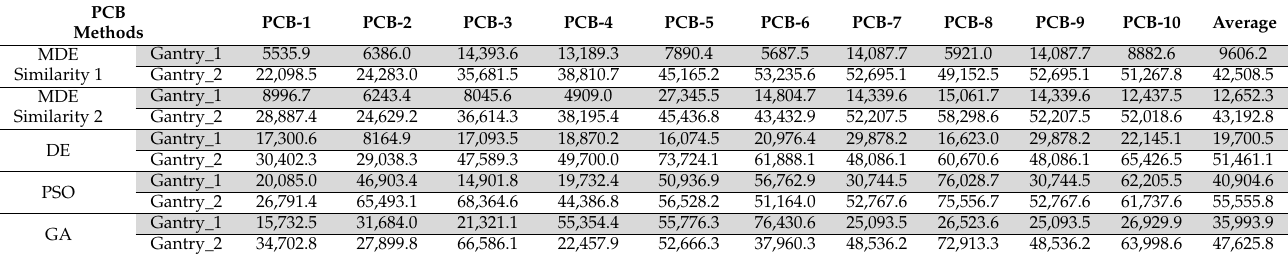
Table 6. Moving distance for picking.